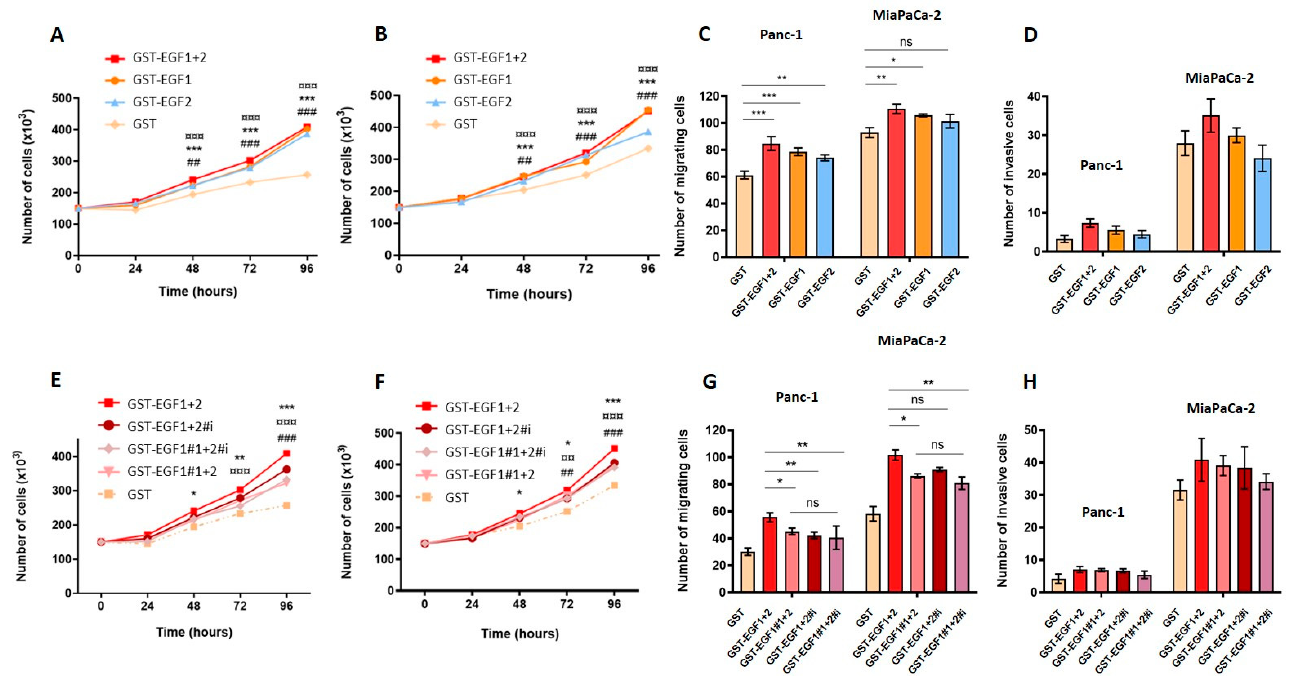
Figure 4. Effects of MUC4 EGF1 and MUC4 EGF2 domains on in vitro proliferation, migration, and invasion of human pancreatic cancer cells. Measurement of cell proliferation in Panc-1 ( A ) and MiaPaCa-2 ( B ) cells after treatment with GST-MUC4 EGF1 , GST-MUC4 EGF2 , GST-MUC4 EGF1+2 , or GST alone (negative control) at 1 µ g/mL. ( A , B ): * Statistically significant difference between GST-MUC4 EGF1 and GST; # statistically significant difference between GST-MUC4 EGF2